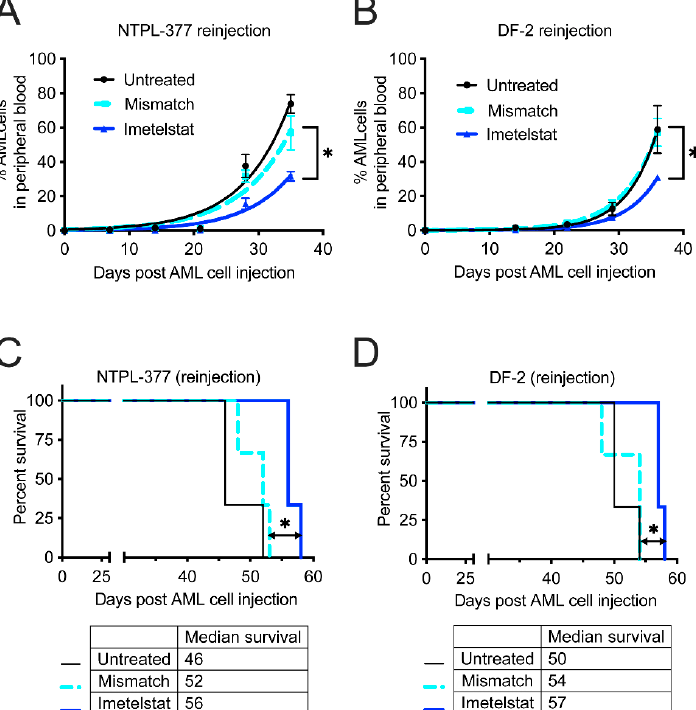
Figure 4. Imetelstat treatment delays engraftment and improves mouse survival in a secondary transplantation study. ( A , B ) Growth curves showing the rise in the percentage of AML (CD45+) cells in mouse peripheral blood. * p < 0.05. ( C , D ) Kaplan-Meier survival plots showing the percent survival in mice, n = 3 each.